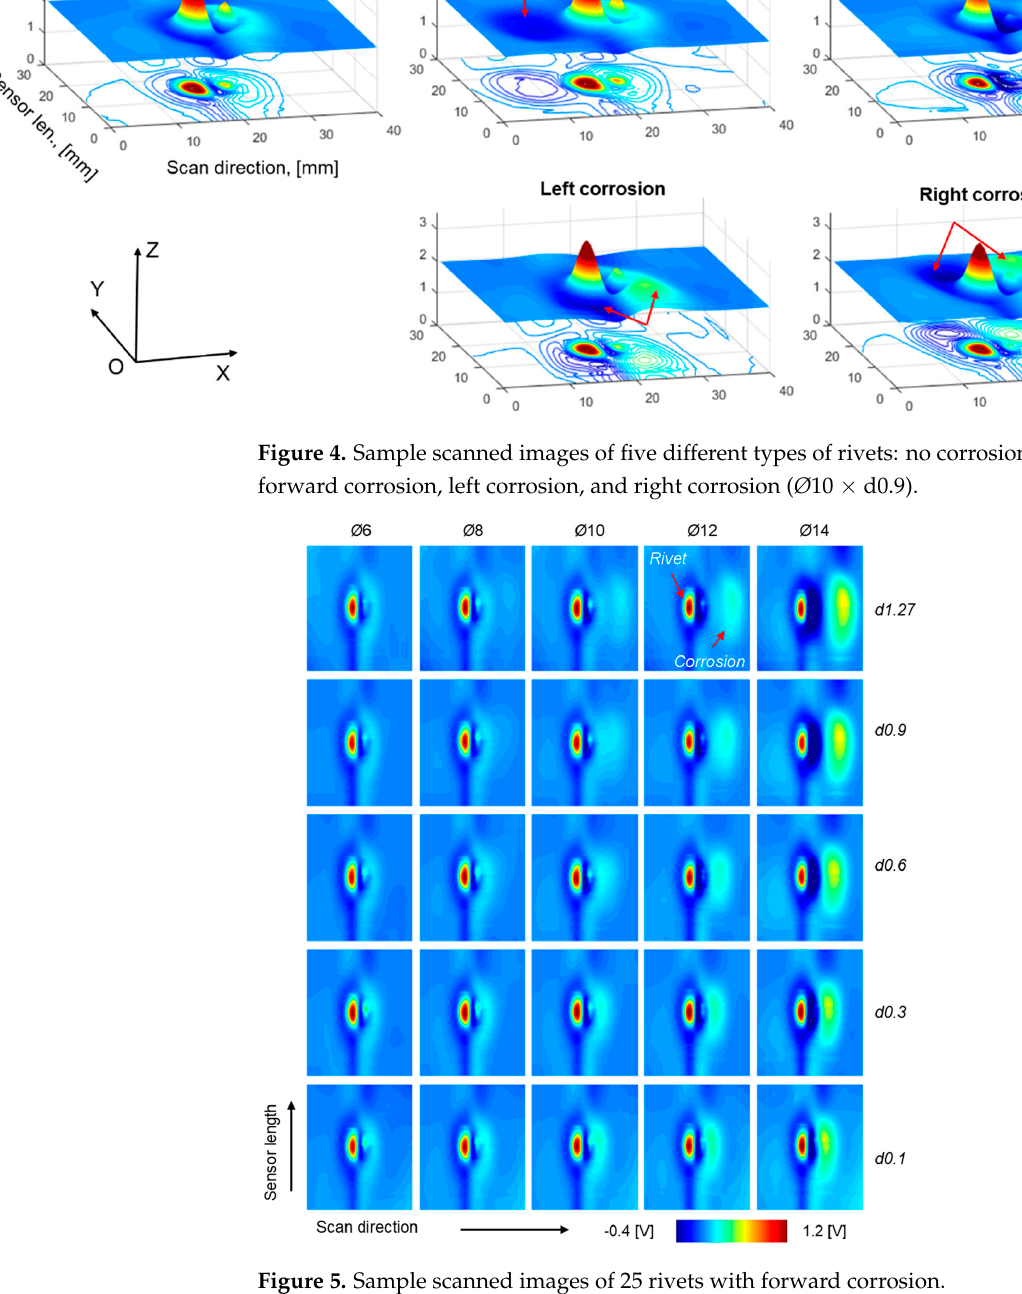
Figure 5. Sample scanned images of 25 rivets with forward corrosion.